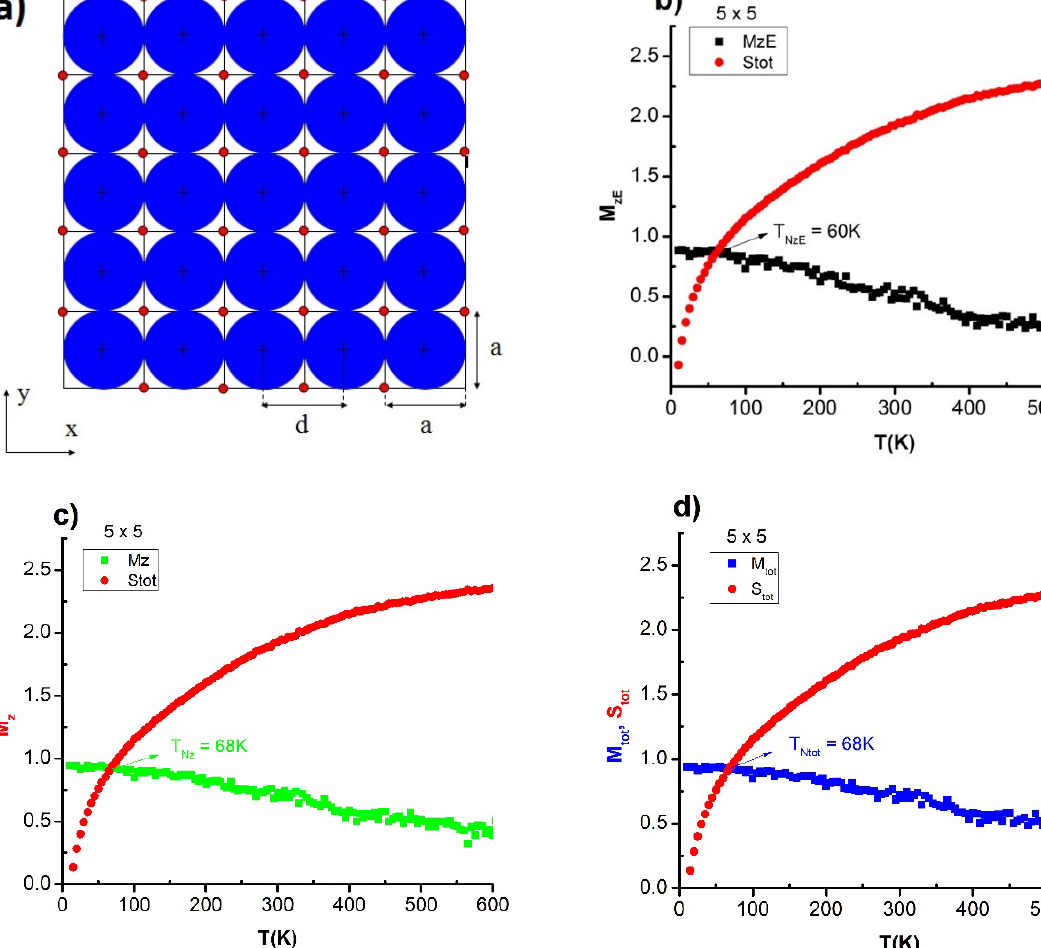
Figure 2. Shape ( a ), the relationship between magnetic characteristic quantities with different temperatures of Fe 2 O 3 nanocomposite thin film with mxm = 5 × 5 (L = 27 nm), nano size (D), D = 6 nm, magnetic field B = 0.1 T, and rotation angle α = 90°. The magnetization in the preferred z -axis ( b ), the magnetization in the z -axis ( c ), and the total magnetization ( d ) with the total entropy.